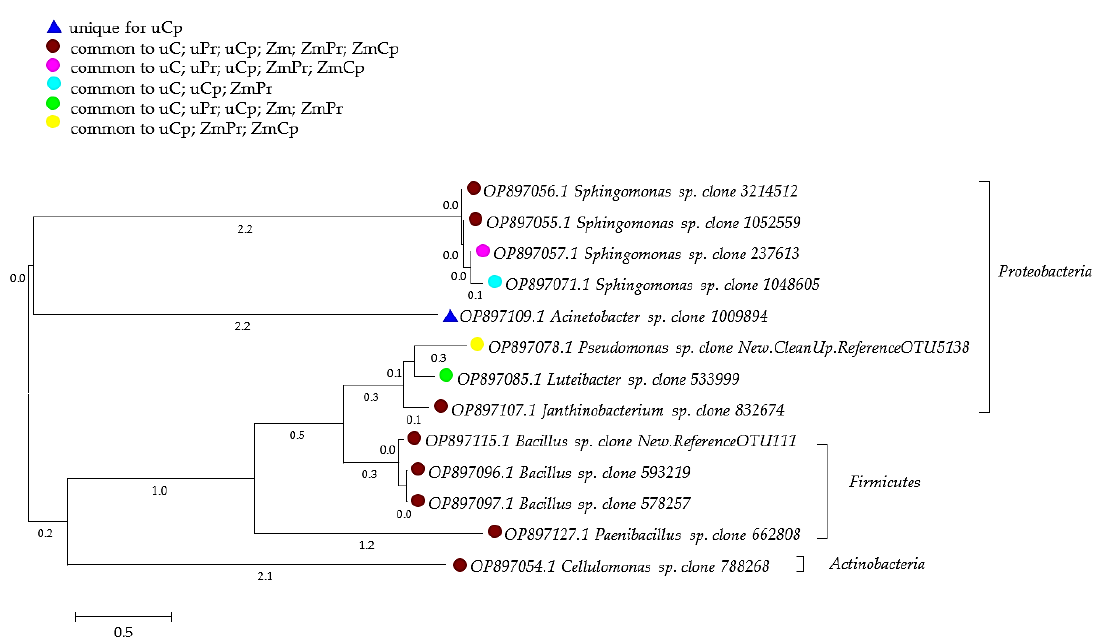
Figure 8. Phylogenetic tree of bacteria isolated from the soil made using the neighbor-joining method. uC — contaminated unsown soil; uPr — sown soil contaminated with permethrin; uCp — sown soil contaminated with cypermethrin; ZmC — uncontaminated soil sown with Zea mays ; ZmPr — soil sown with Zea mays contaminated with permethrin; ZmCp — soil sown with Zea mays contaminated with cypermethrin.